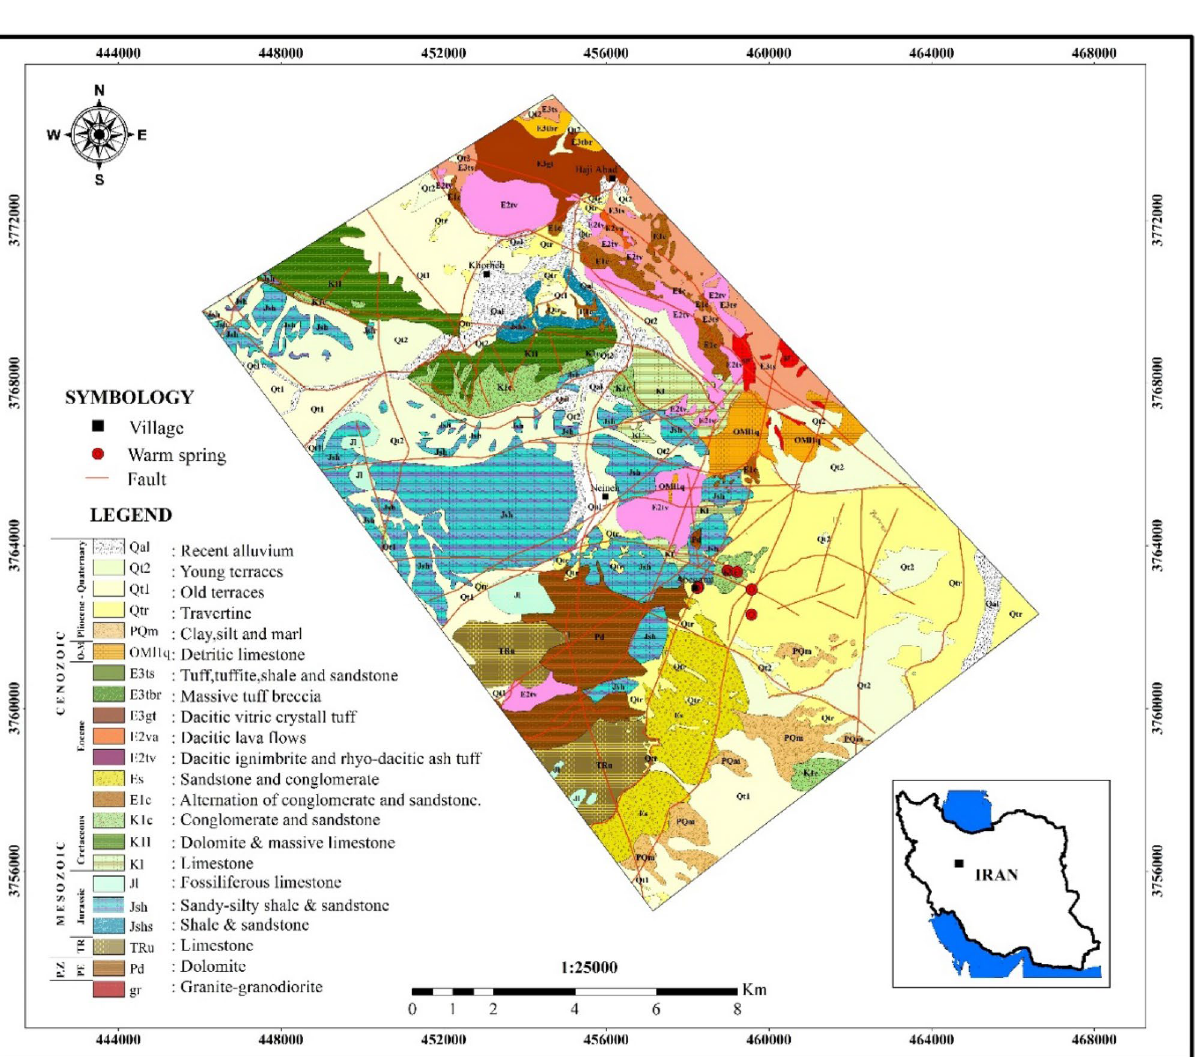
Figure 3. Detailed Geological map of the Mahallat Region (with 1:25,000